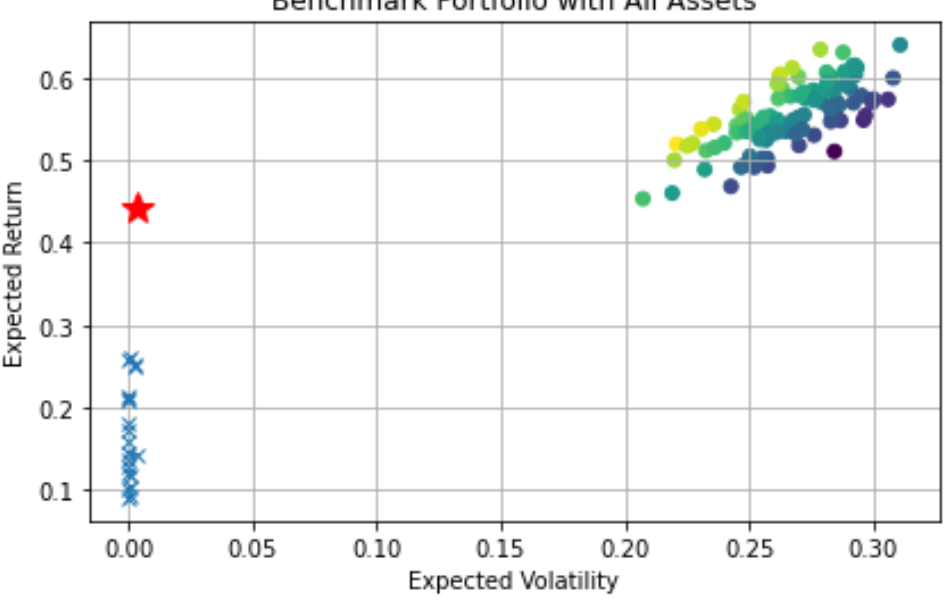
Figure 21. Benchmark portfolio optimization: Monthly expected risk and